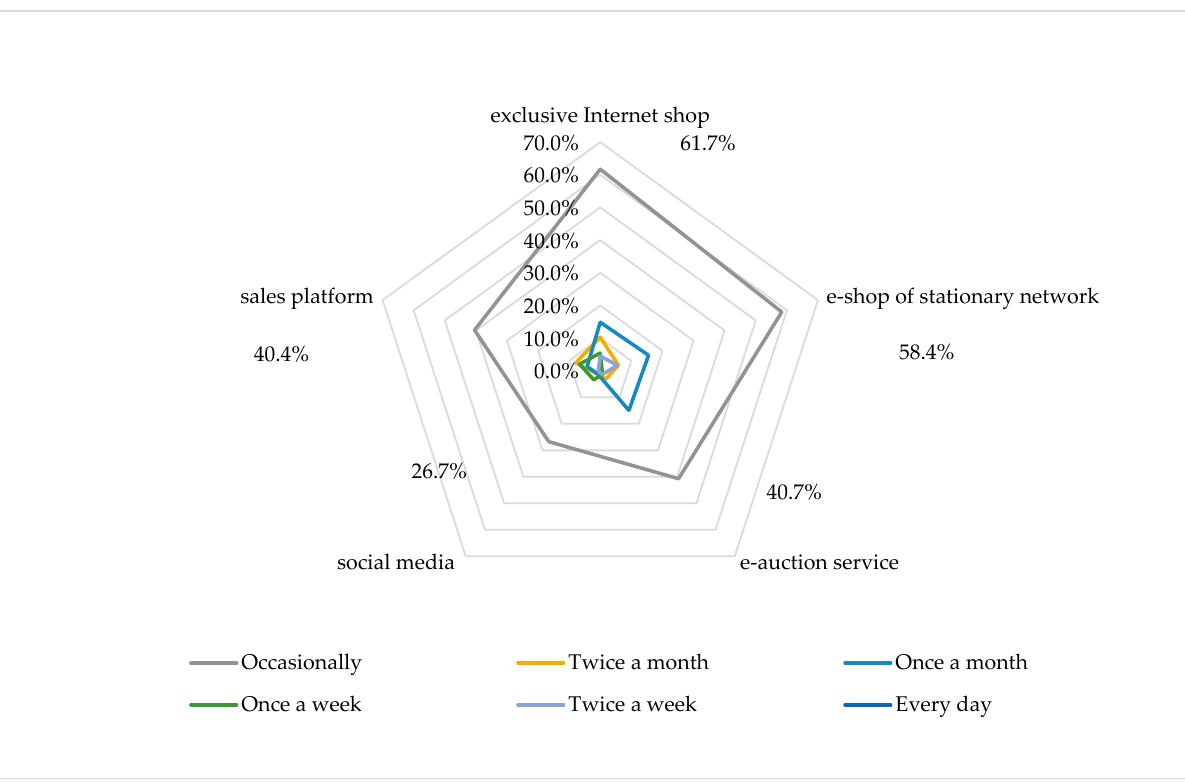
Figure 1. Declarations of the frequency of purchases in selected sales units operating on the Internet before the pandemic COVID-19.